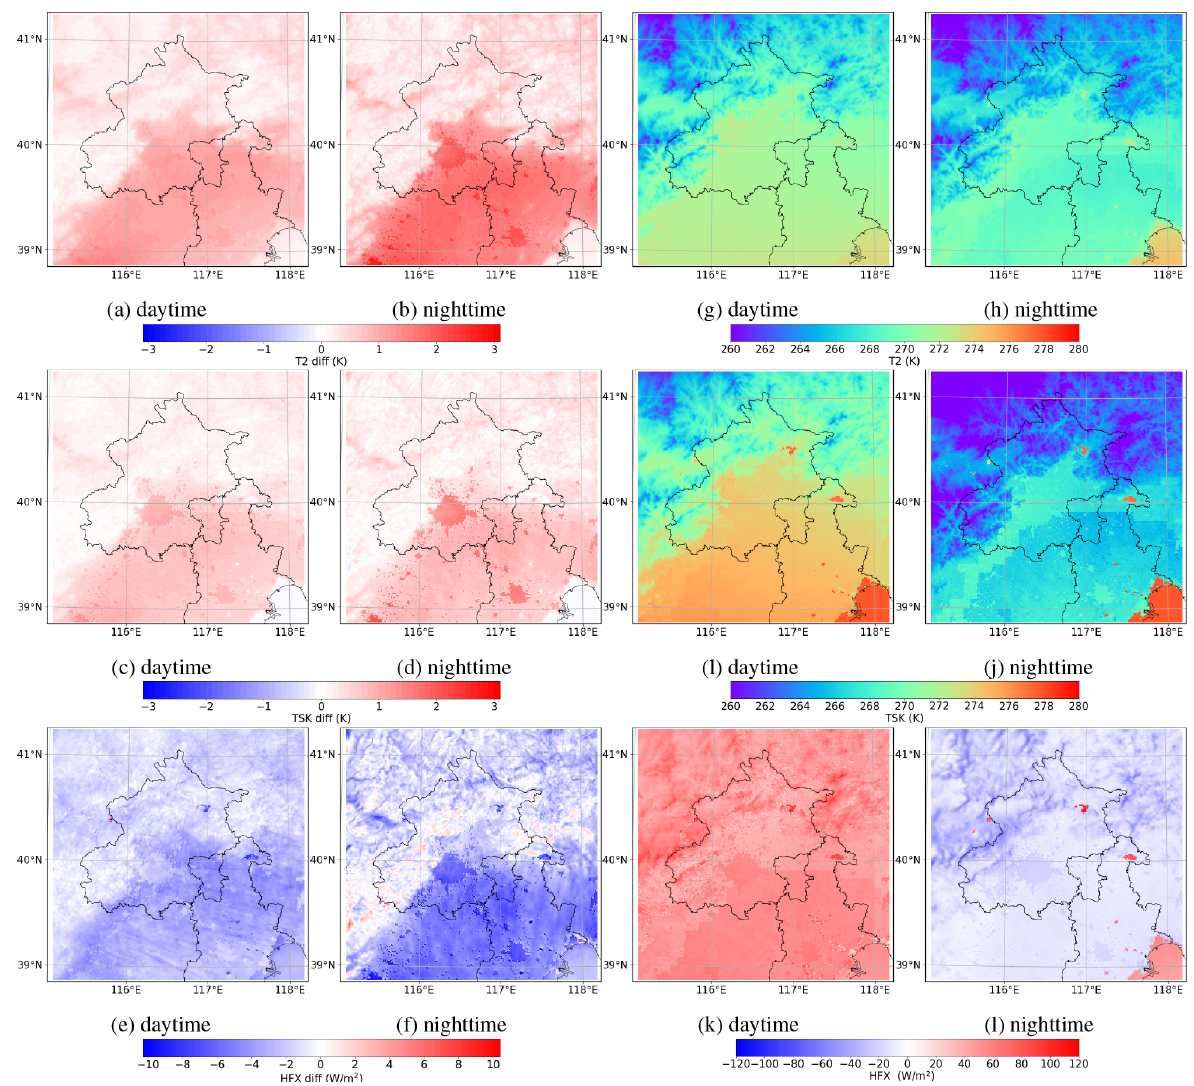
Figure 6. Spatial distribution of the mean difference (ACM2_1.0 minus ACM2_0.01) in (a, b) the 2m temperature (T2), (c, d) the surface skin temperature (TSK), and (e, f) the sensible heat flux (HFX) over the daytime and the nighttime. The actual values of (g, h) T2, (i, j) TSK, and (k, l) HFX simulated by ACM2 with the default K z min value (i.e., ACM2_0.01) during the daytime and the nighttime are also displayed for